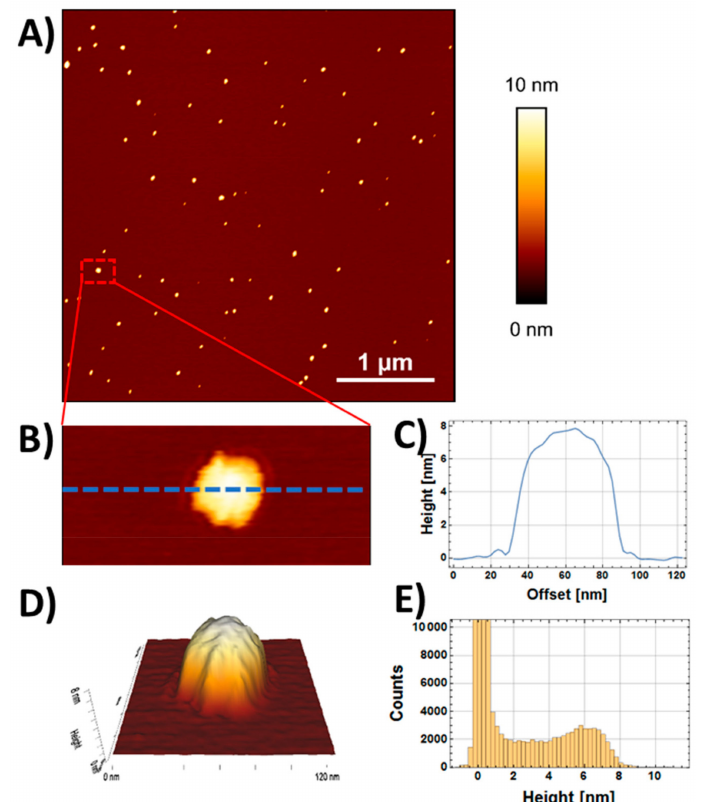
Figure 1. AFM characterization of non-functionalized gold nanoparticles (NP) on mica substrate. ( A ) Representative AFM image of AuNPs deposited on mica (4 × 4 µ m 2 , 2048 × 2048 pixel, Z-scale 5 nm). ( B ) Digital zoom and section line. ( C ) Height profile obtained along the section shown in panel B. ( D ) 3D morphological reconstruction of a single AuNP obtained from the AFM measurements. ( E ) Statistical distribution of measured height of the image shown in panel